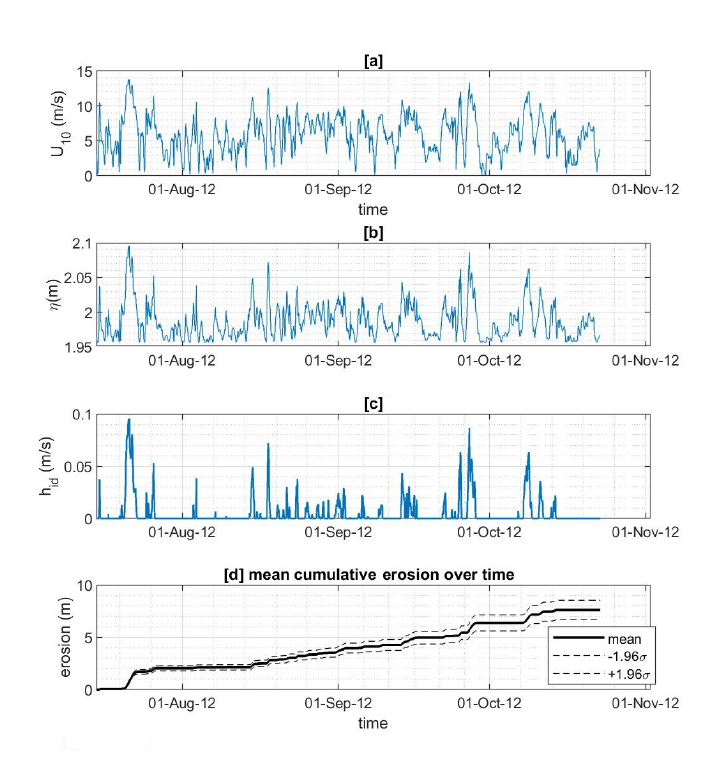
Figure 13. Cumulative erosion over the summer of 2013 in Case #1. Subfigure ( a ) displays the wind speed during the summer of 2013. The wind speed data are the major input for the storm surge module which calculates the storm surge level shown in subfigure ( b ), which in turn is used to find the inundation depth h id in subfigure ( c ). Finally, the coastal erosion overtime is calculated for each case of n = 1000 in the Monte Carlo simulation. The distribution of the calculated erosion rate follows a normal distribution. Shown in the subfigure ( d ) are the mean erosion (thick black line) with ± 1.96 σ drawn as dotted lines ( σ = standard